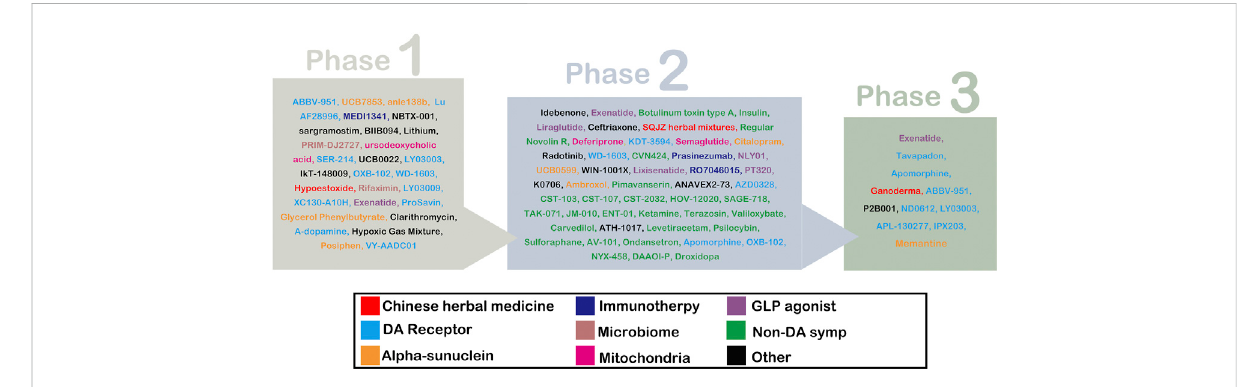
FIGURE 1 List of drug-modifying therapies and symptomatic therapies for